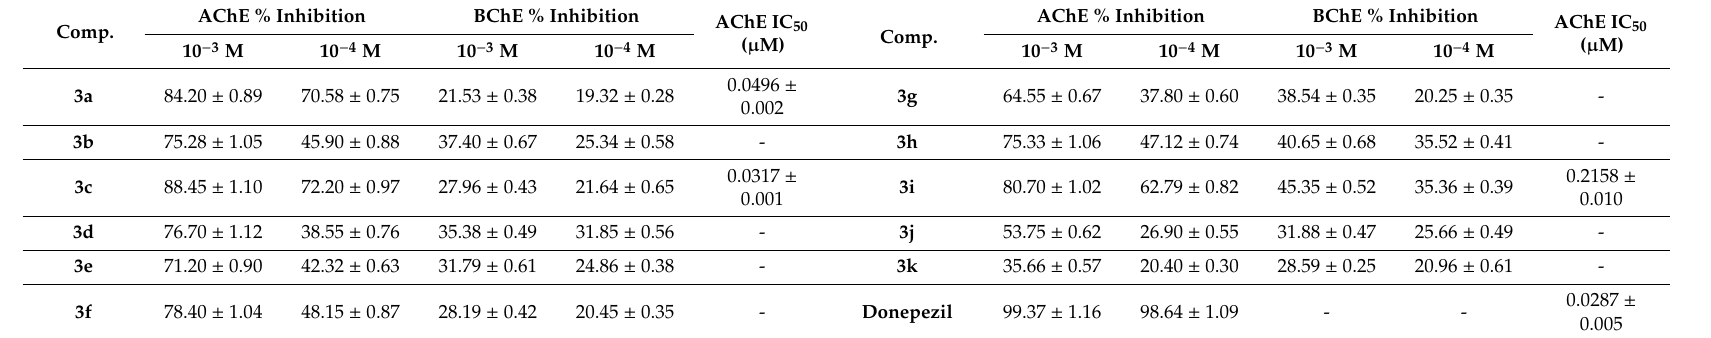
Table 1. Inhibition (%) of compounds 3a – k against AChE and butyrylcholinesterase (BChE) enzymes. Comp.